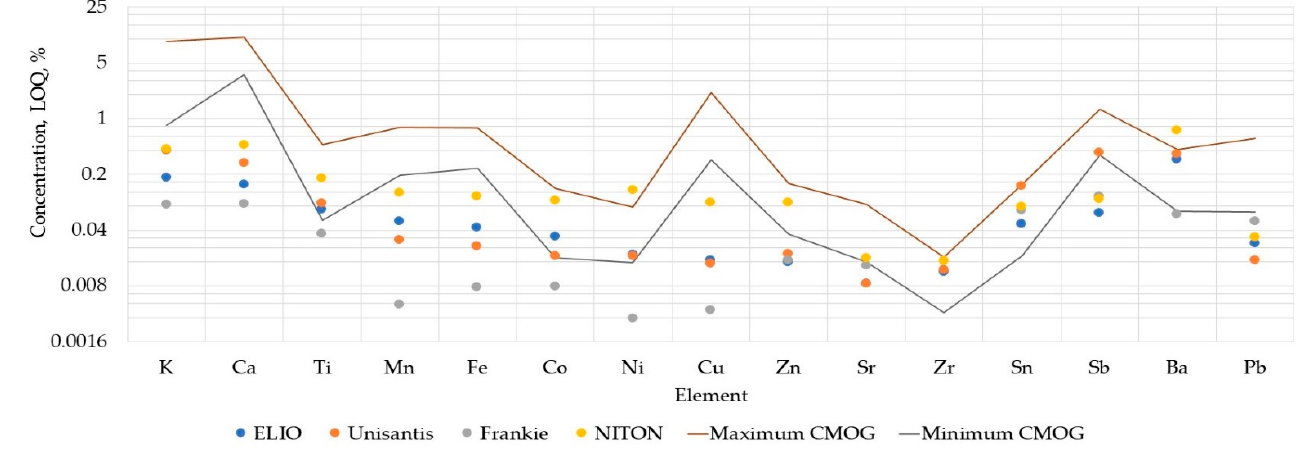
Figure 1. Comparison of the LOQ estimation of different units. The concentration range of CMOG A, B, and D reference glasses covers the space between the lines. Logarithmic scale.